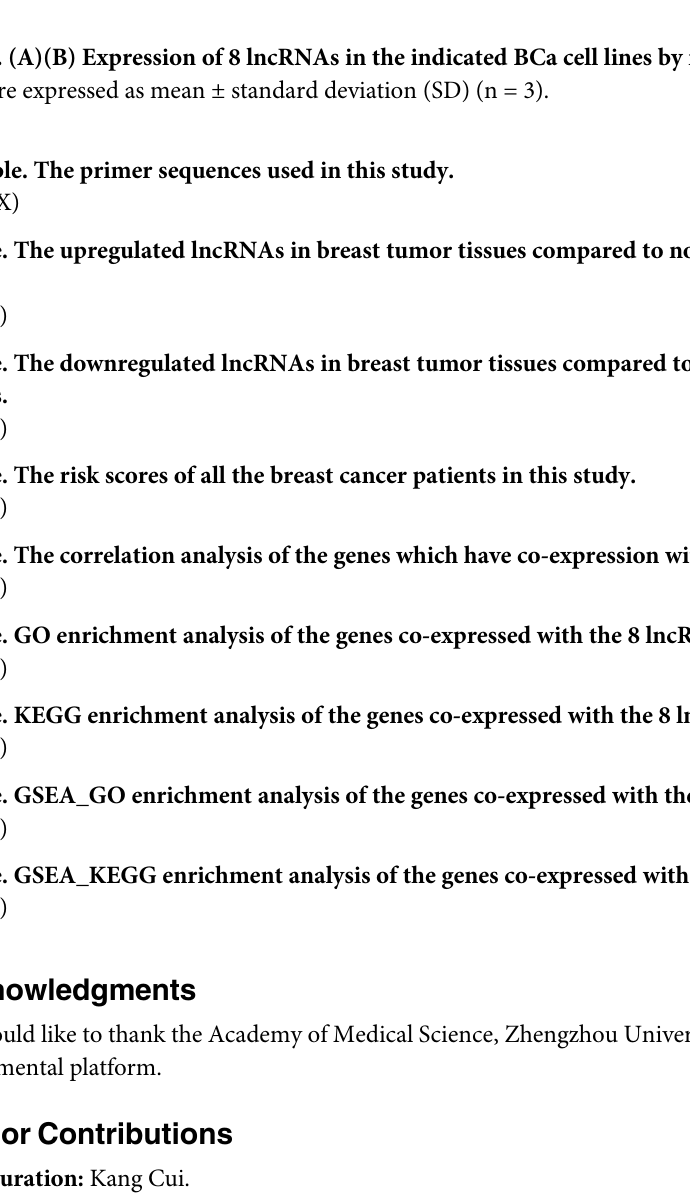
S2 Fig. ROC analysis of single lncRNA. S3 Fig. (A)(B) Expression of 8 lncRNAs in the indicated BCa cell lines by real-time PCR. Data are expressed as mean ± standard deviation (SD) (n = 3). S1 Table. The primer sequences used in this